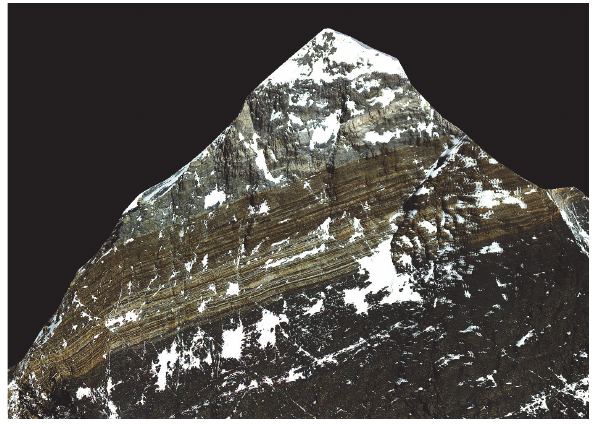
Figure 6. The southern flank of the Mt. Everest’s summit with a GSD of circa 15 cm (3D point cloud snapshot).